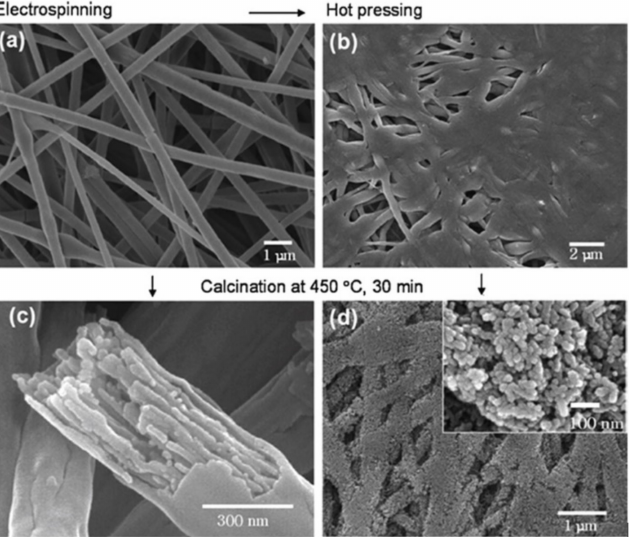
Figure 28. Electrospinning and hot pressing of metal oxide materials: ( a ) SEM image of as-spun TiO 2 /PVAc composite fibers fabricated by electrospinning from a DMF solution; ( b ) SEM image of TiO 2 PVAc composite fibers after hot pressing at 120 ◦ C for 10 min; ( c ) SEM image of unpressed TiO 2 nanofibers after calcination at 450 ◦ C; ( d ) SEM images with different magnifications of hot-pressed TiO 2 nanofibers after calcination at 450 ◦ C. Reprinted with permission from [348]. Copyright 2006 American Chemical Society.